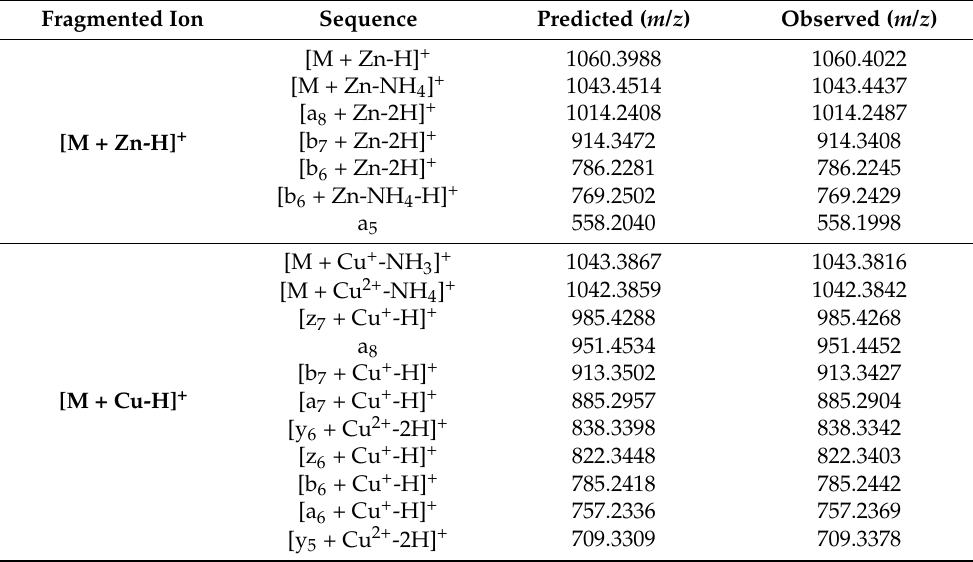
Figure 8. Tandem mass spectrometry (MS/MS) spectrum of the doubly charged ( A ) [M + Zn] 2+ ion at m / z 529.7 and ( B ) [M + Cu] 2+ ion at m / z 529.2, showing the y, z and a, b fragments of the peptide sequence. Table 2. Collision-induced dissociation of [M + Zn]2+ and [M + Cu]2+ ions. Table 1. Collision-induced dissociation of [M + Zn-H] + and [M + Cu-H] + ions. Fragmented